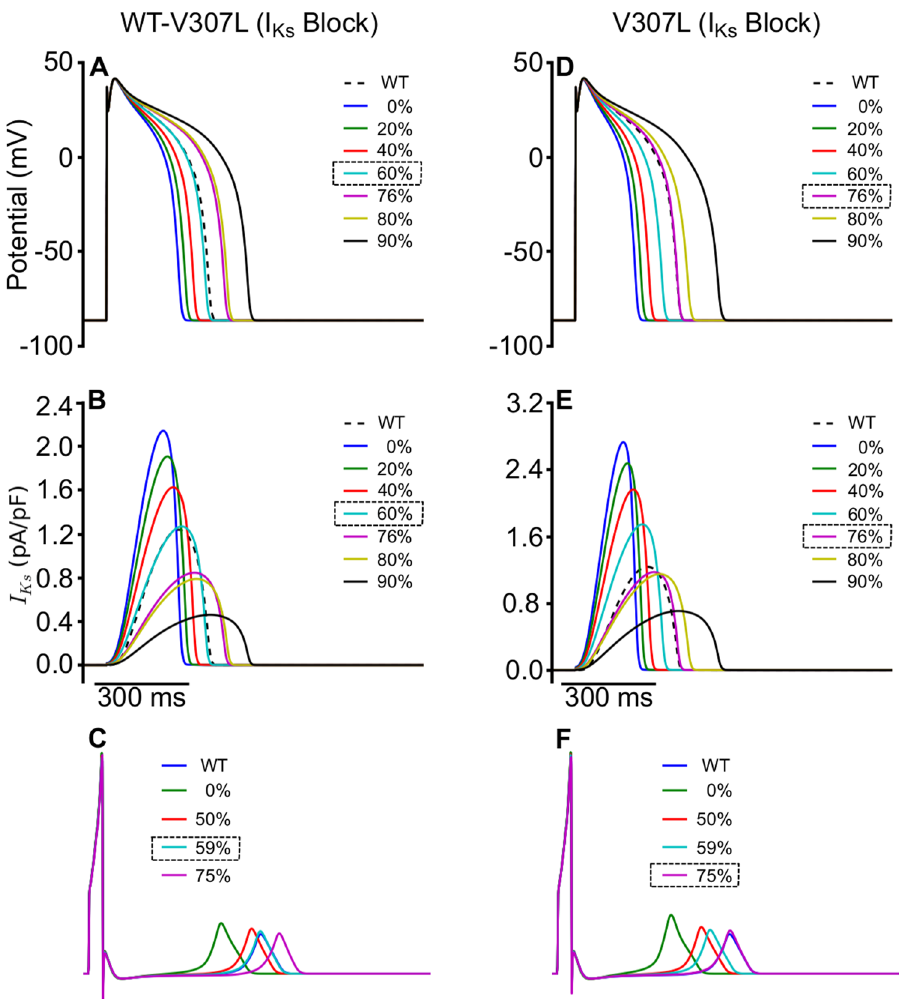
Figure 7. I Ks blockade in single cell and 1D simulations. Action potentials in WT-V307L ( A ) and V307L ( D ) conditions under varying degrees of I Ks blockade. The dashed line represents the WT and the boxed percentage represents the degree of I Ks block required to normalize the APD under the respective mutation condition. I Ks profiles corresponding to the APs shown in ( A ) and ( D ) are shown for WT-V307L ( B ) and V307L ( E ) conditions, respectively. Pseudo-ECGs corresponding to varying degrees of I Ks blockade are shown in WT- V307L ( C ) and V307L ( F ) conditions. The blue line represents the WT and the boxed percentage represents the degree of I Ks block required to normalize the QT interval under the respective mutation